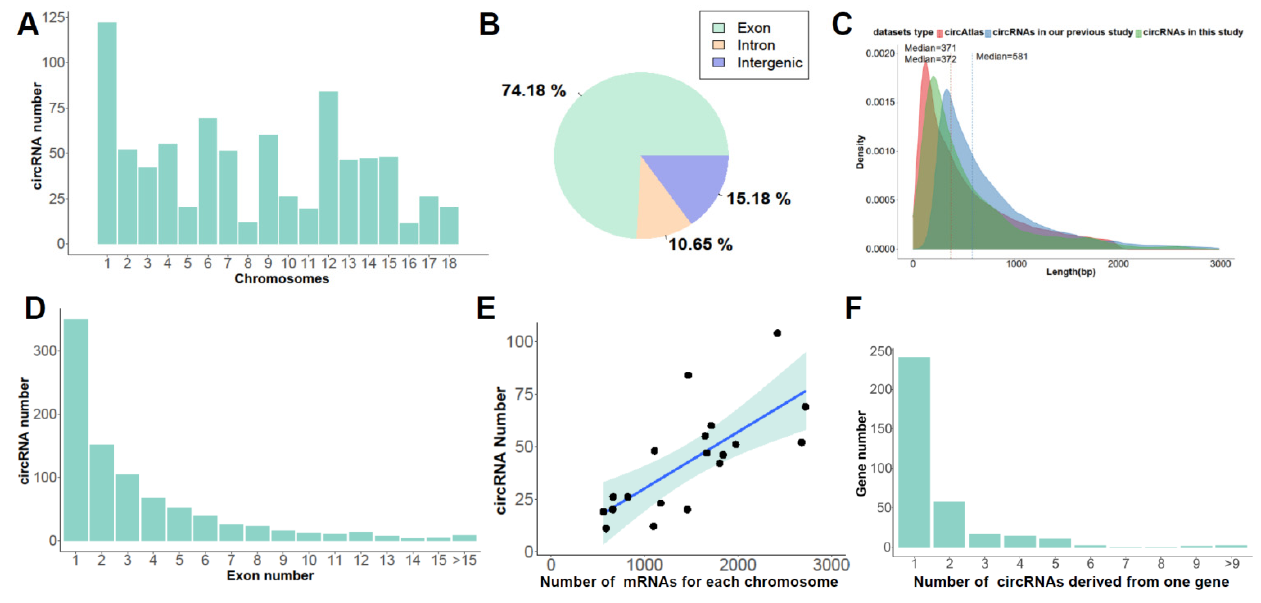
Figure 2. Molecular characteristics of Ssc circRNAs in subcutaneous fat tissues. ( A ) The distribu- tion of circRNAs on the Sus scrofa chromosomes. ( B ) The distribution of circRNAs in genomic regions. ( C ) The comparison of circRNA length with other datasets. ( D ) Exon number of forming circRNAs. ( E ) The correlation between the number of circRNAs and the mRNAs for each chromosome. ( F ) The number of circRNAs generated from the host genes.